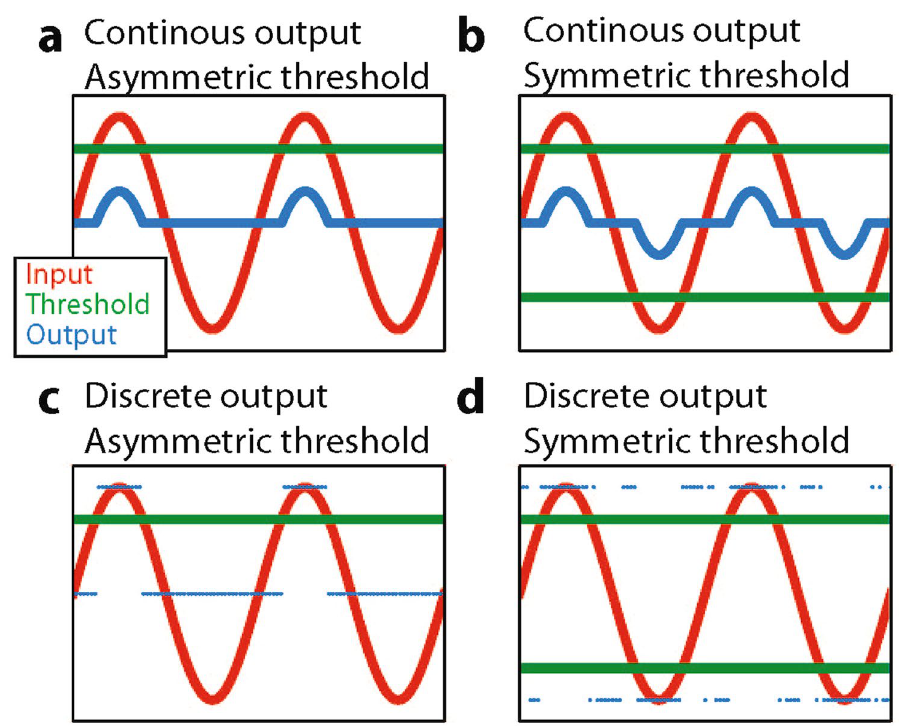
Figure 3. Detector models. Sketch, demonstrating the reponse of different sensor types to a sinusoidal input siganl (red line). We compare the four cases of continuous ( a , b ) or discrete ( c , d ) output (blue lines or dots, respectively) and with asymmetric ( a , c ) or symmetric ( b , d ) thresholds (green